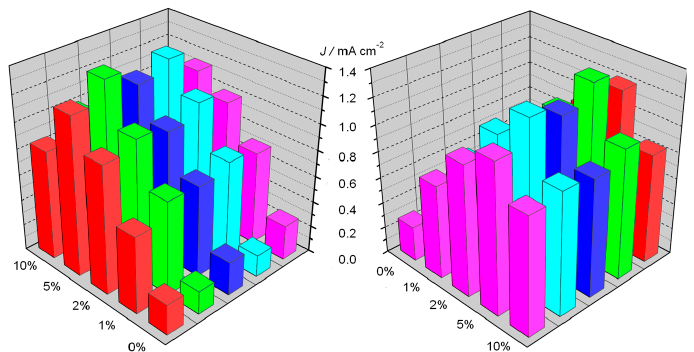
Figure 7. Comparison of the photoactivity of different batches (colored bars) of modified and un-modified hematite electrodes measured under AM 1.5 illumination. The histogram is shown from two different perspectives for clarity. Nominal titanium concentrations are reported in the x-axis.